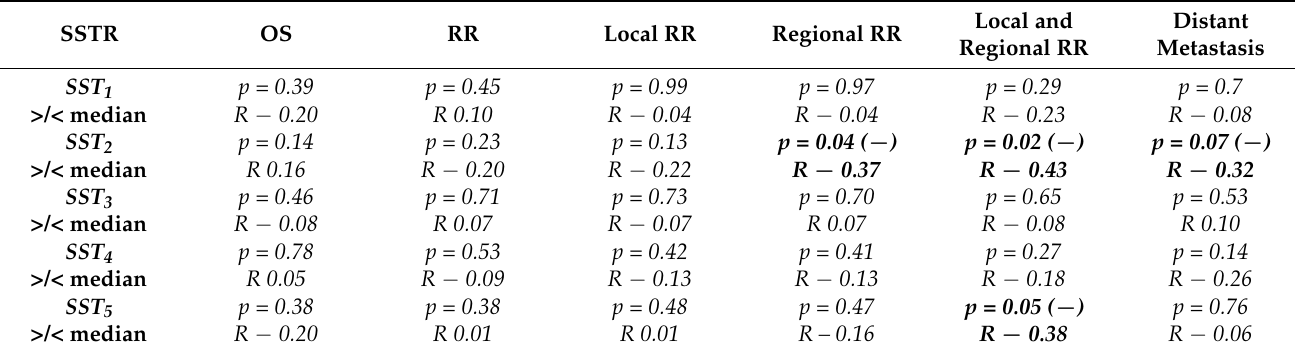
Table 1. In vivo association between SST-subtypes expression in OSCC with overall survival (OS), recurrence rate (RR), and distant metastasis. SSTs expression is expressed as categorical with “>/< median” analysis. The p -values were calculated with the log-rank test for the analysis between SSTR >/< median analysis and OS, overall RR, local RR, regional RR, local and regional RR, and distant metastasis.